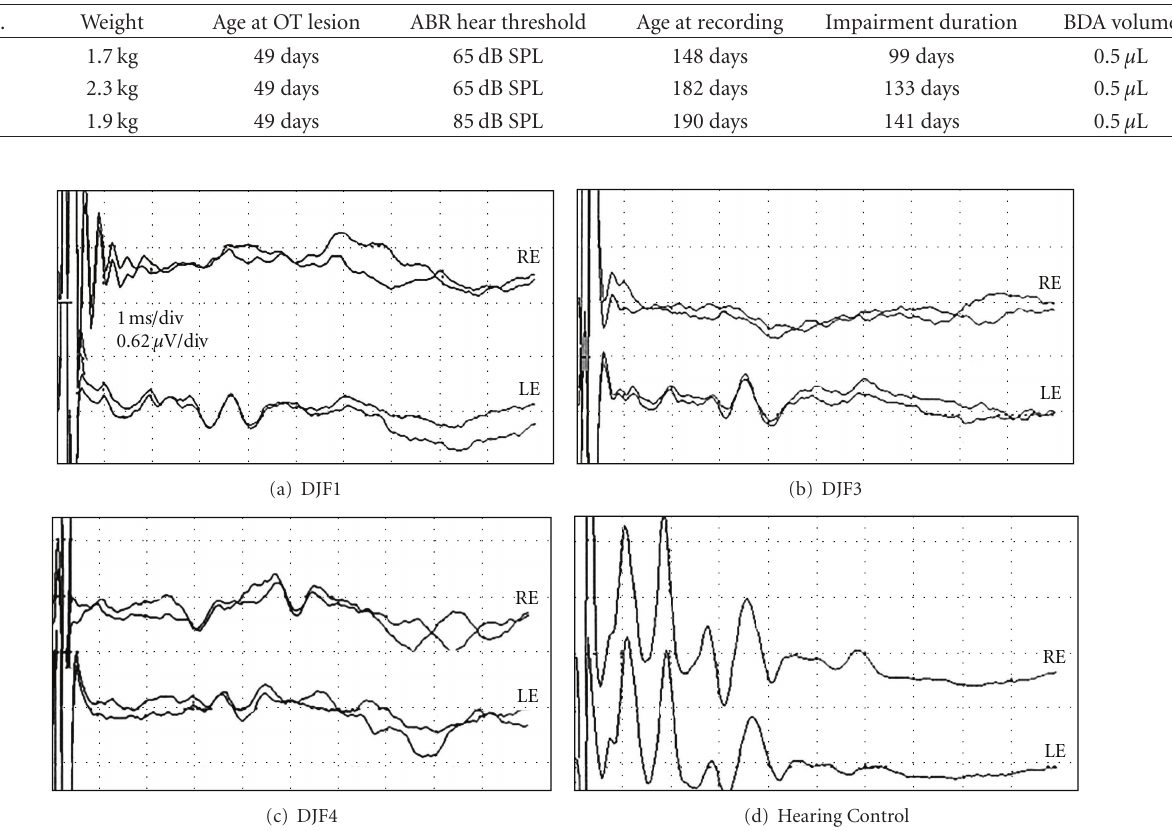
Figure 1: Auditory brainstem response (ABR) data for ferrets with early hearing loss (a–c) or normal hearing (d). For each panel, the auditory stimulus was a calibrated click (90dB SPL; 0.1 ms square-wave click, rarefaction), delivered through a speaker positioned directly in front of one ear (RE = right; LE = left). Each waveform represents the average of 2000 trials; overlapped dual waveforms indicate that the test was repeated. Scale, indicated in panel (a), is the same for each panel. As evidenced by comparison of panels “a–c” with that of the hearing control in (d), all ferrets with early hearing loss demonstrated profoundly reduced ABRs to 90 dB SPL stimuli. However, some residual auditory response was apparent in each of the treated animals, as demonstrated by the small but repeatable peaks at approximately 3ms latency. Further tests (not depicted) indicated that hearing thresholds for the treated animals ranged from 65 to 85 dB SPL (see Table